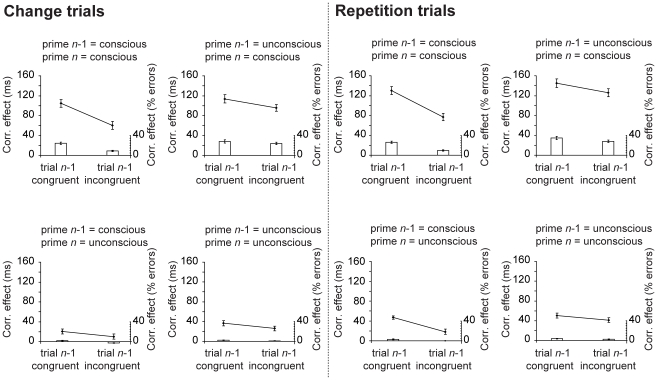
Conflict adaptation results for repeat and change trials separately.Correspondence effects in trial n for RTs (mean RT on incongruent trials–mean RT on congruent trials) and error rates (mean percentage of errors on incongruent trials–mean percentage of errors on congruent trials) as a function of prime-target correspondence in trial n-1 (congruent vs. incongruent), masking strength in trial n-1 (weak vs. strong masking), and masking strength in trial n. Correspondence effects are reported for a dataset containing trials without stimulus/response repetitions (change trials) and trials with stimulus/response repetitions only (repetition trials).